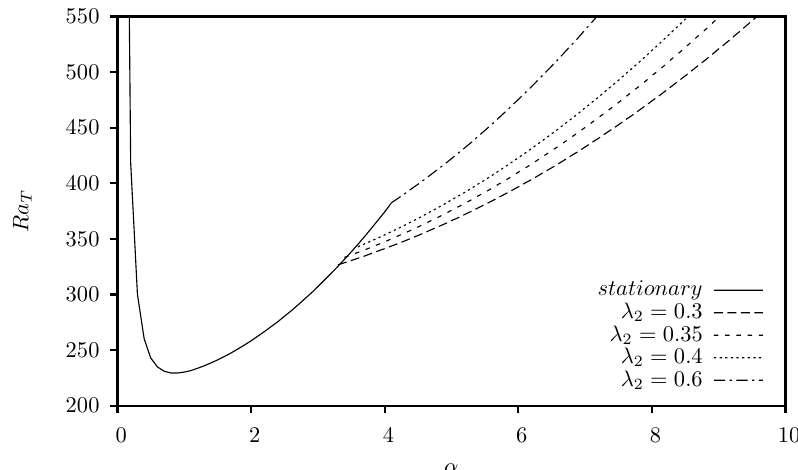
Figure 6. Effect of λ 2 on the marginal stability curves for oscillatory convection with respect to the wave number α .